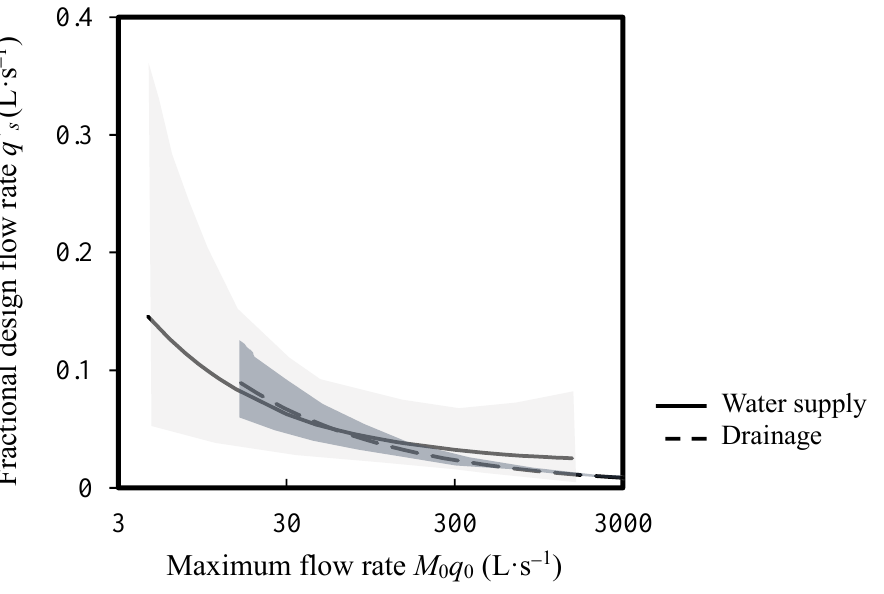
Figure 4. Model estimated fractional design flow rates against maximum flow rates. (Shaded area indicated one standard deviation plus and minus the average estimates).